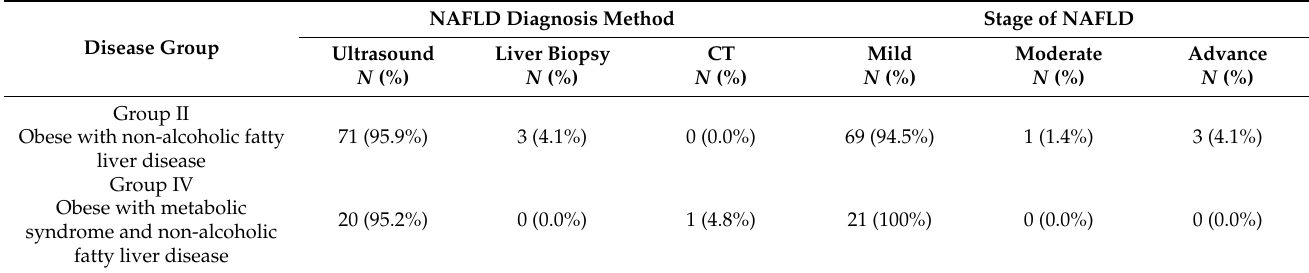
Table 2. NAFLD diagnostic method and baseline stage in obese subjects diagnosed with NAFLD.